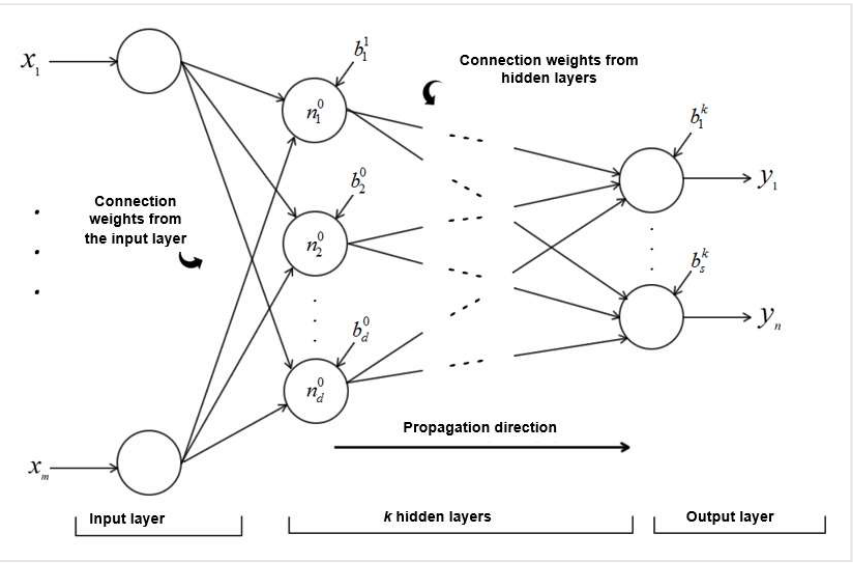
Figure 2. General architecture of an extreme learning machine.